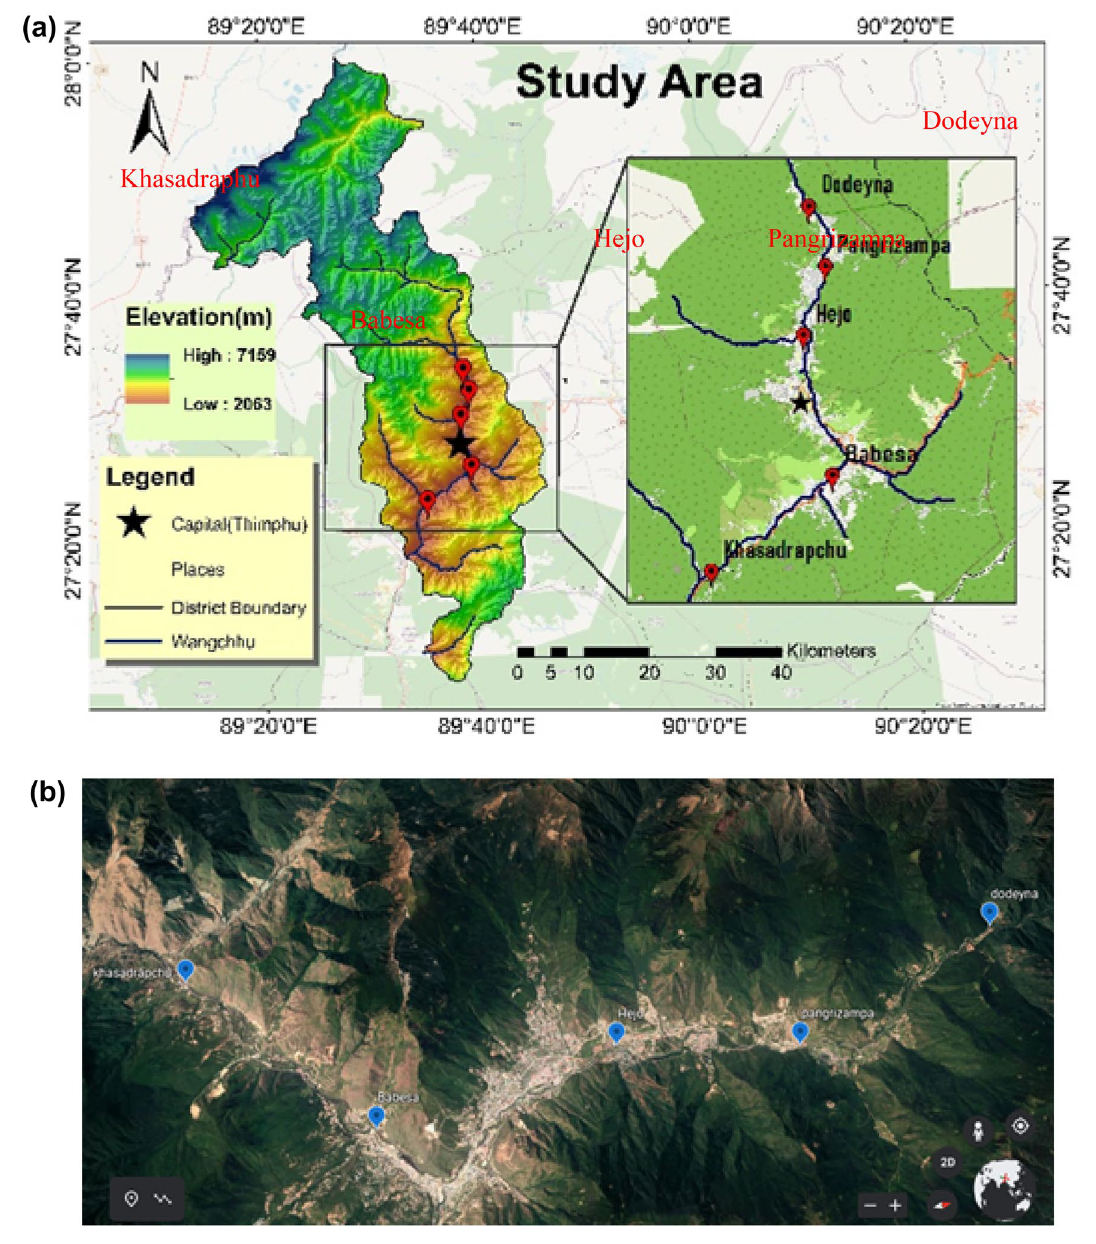
Fig. 4 a Map of study area. b Wangchu River basin and sampling